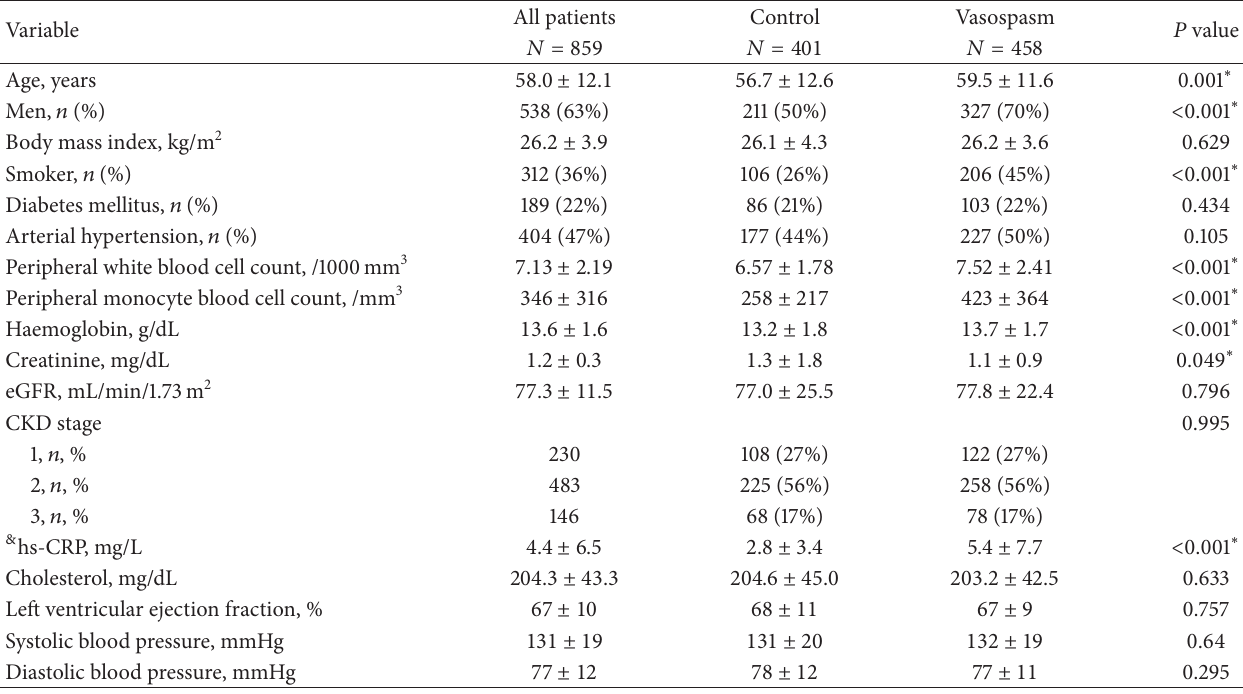
Table 3: Baseline characteristics of study patients.